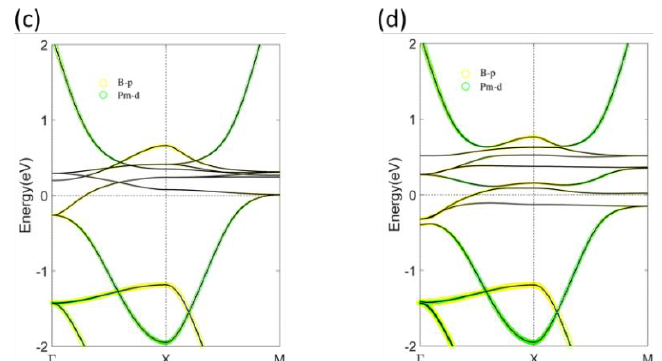
Figure 10. PBE band structure of PmB 6 without SOI ( a ) and with SOI ( b ). The size of blue, green and yellow circles show contributions from Pm-f, Pm-d and B-p orbitals, respectively. ( c ) Zoom-in of ( a ). ( d ) Zoom-in of ( b ). ( c , d ) demonstrate SOI-induced band inversion and gap opening.